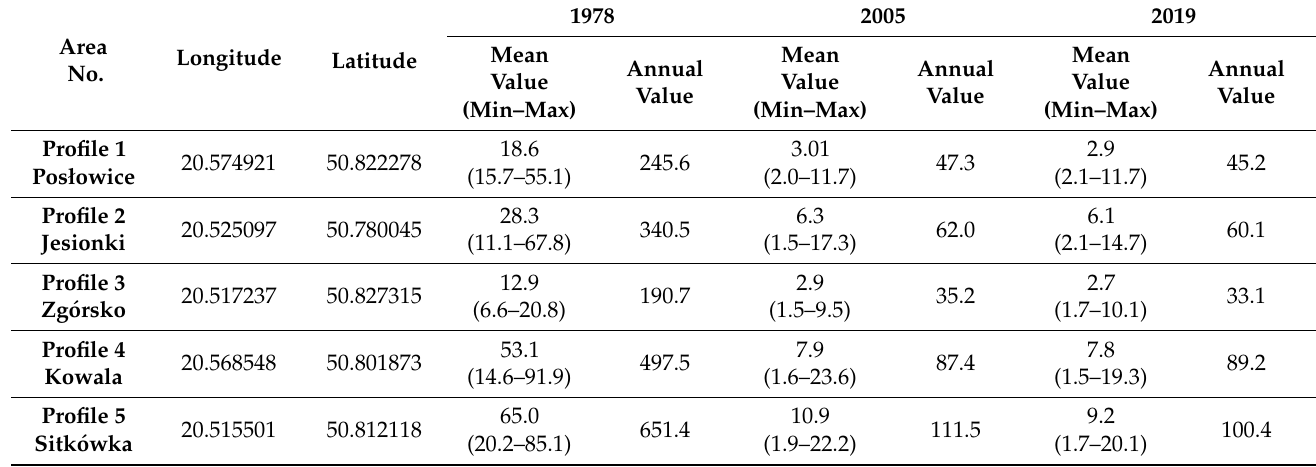
Table 1. Amount of dust fall at selected research positions per g/m 2